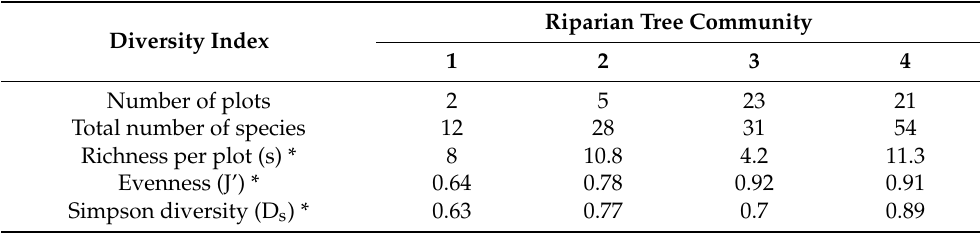
Table 3. Species diversity indices for the riparian tree communities of the Acom é riverbank. Diversity